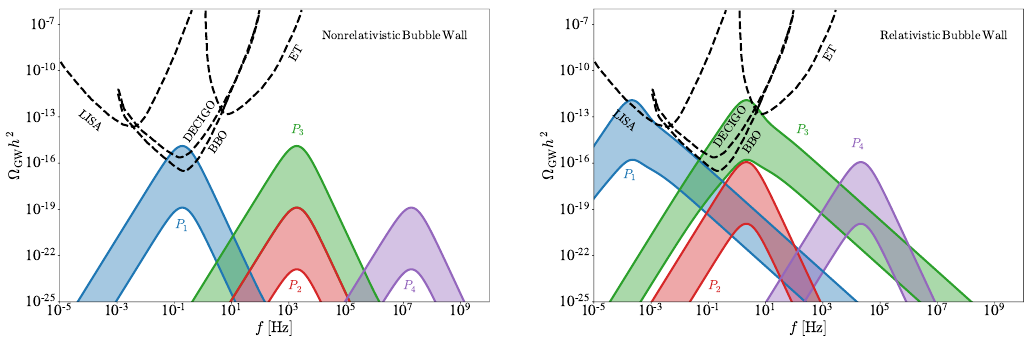
Figure 6 . Spectrum of stochastic gravitational waves produced by a FOPT. The four bands repre- sent phase transitions with: ( T, β H ) = (10 3 GeV , 1) (P1, blue), (10 3 GeV , 10 4 ) (P2, red), (10 7 GeV , 1) (P3, green), and (10 7 GeV , 10 4 ) (P4, purple) with latent heat values α ≥ 0 . 01 . The black dashed lines show projected experimental reaches from the future experiments LISA, DECIGO, BBO, and